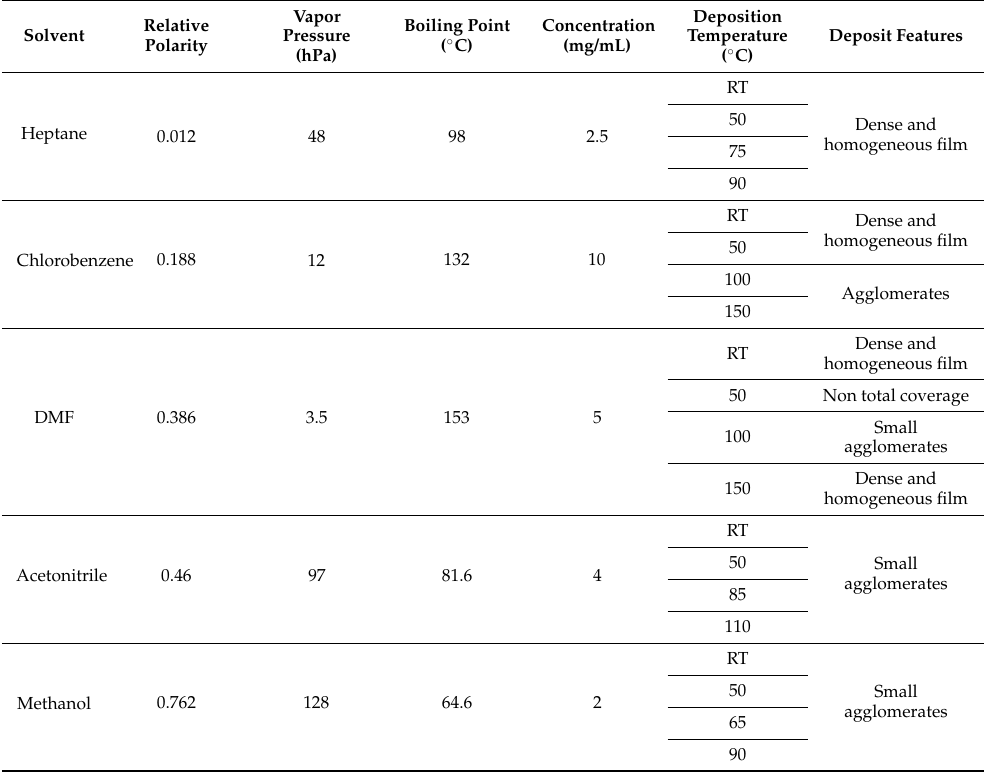
Table 1. Conditions for the solutions of compounds A–D in each solvent and temperature used for the film deposition via the doctor blade